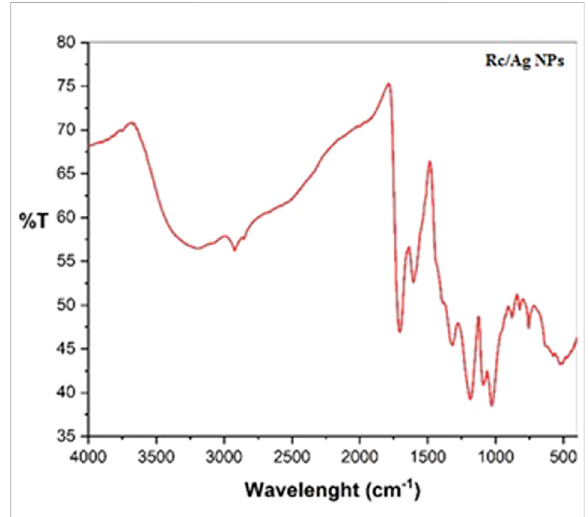
FIGURE 3 FTIR spectrum of Ag nanoparticles obtained by sumac- mediated green